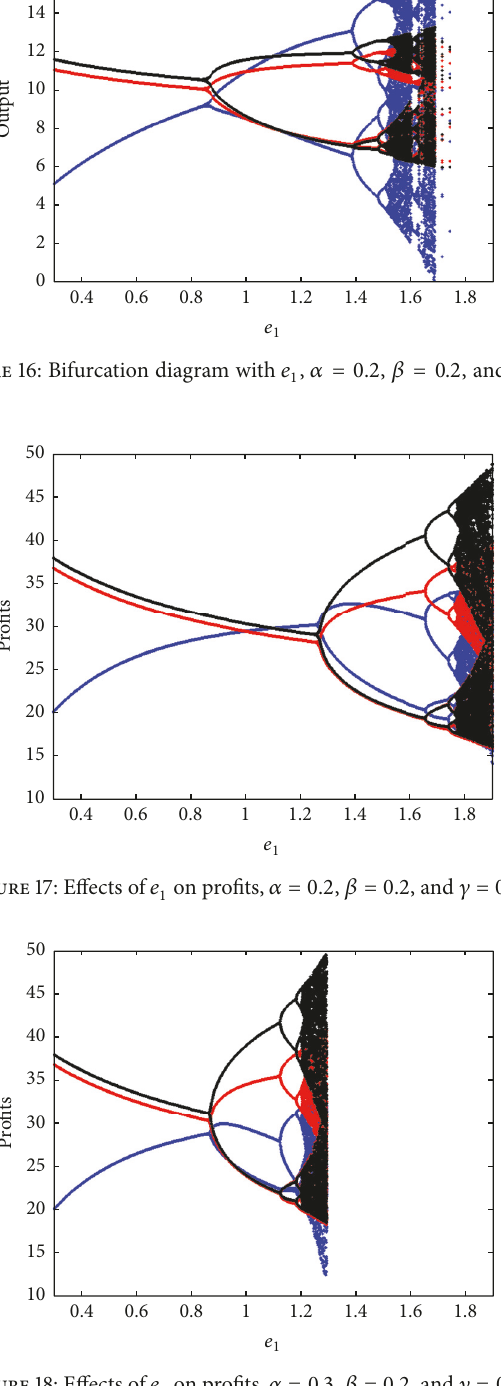
Figure 18: Effects of 𝑒 1 on profits, 𝛼 = 0.3 , 𝛽 = 0.2 , and 𝛾 = 0.1 .